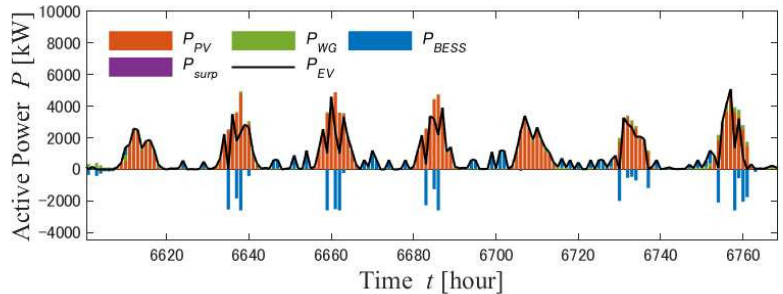
Figure 16. Generated power and load from January 1 to 7 (Case 1).